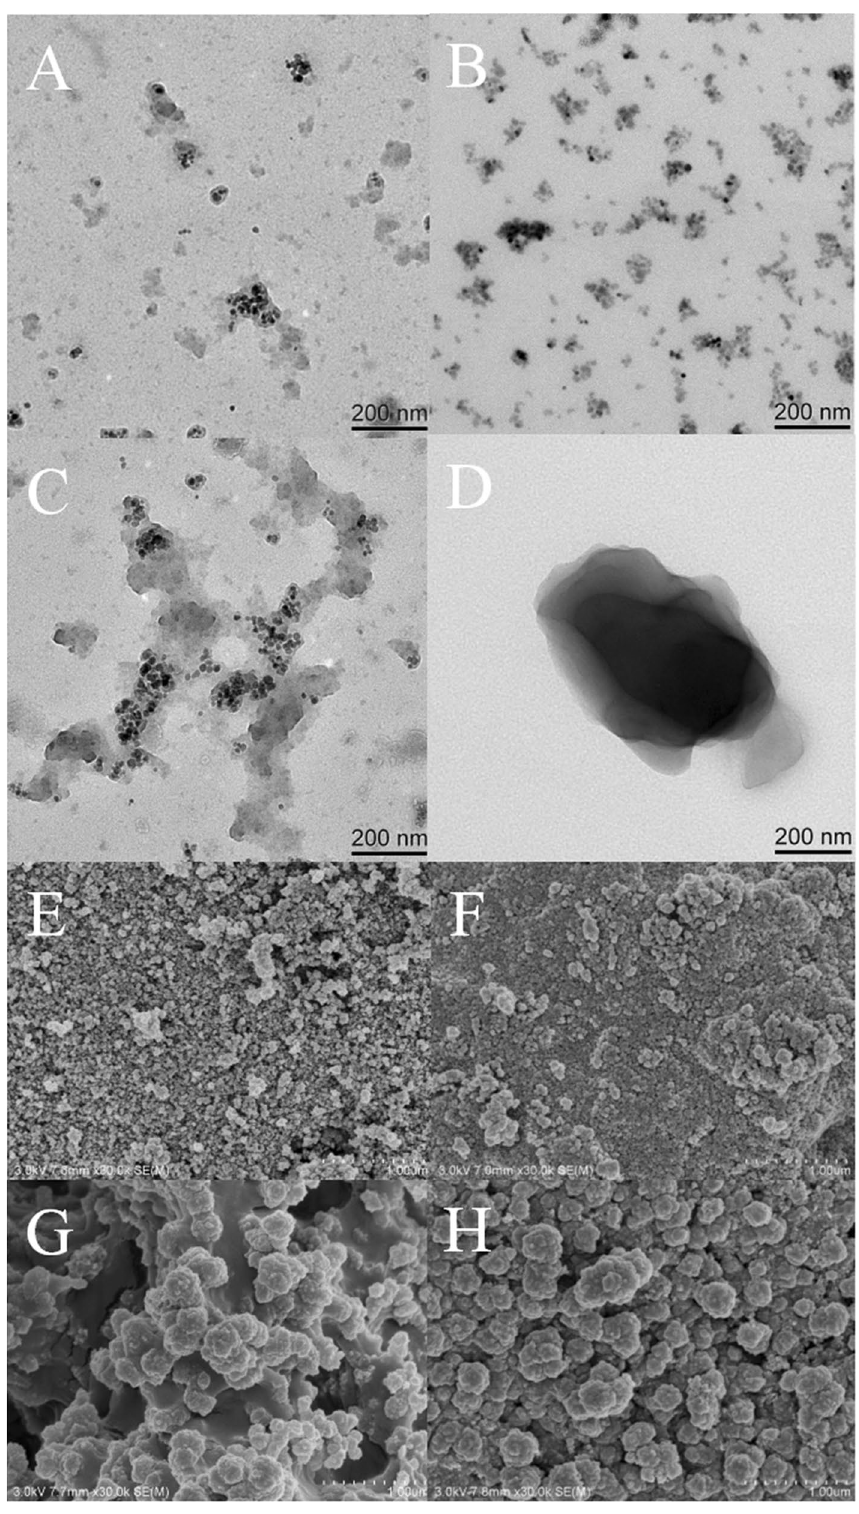
Figure 3. TEM images of the Fe 3 O 4 ( A ), Fe 3 O 4 @SiO 2 ( B ), Fe 3 O 4 @SiO 2 –CH 2 =CH 2 ( C ) and Gen-MMIPs ( D ). SEM images of the